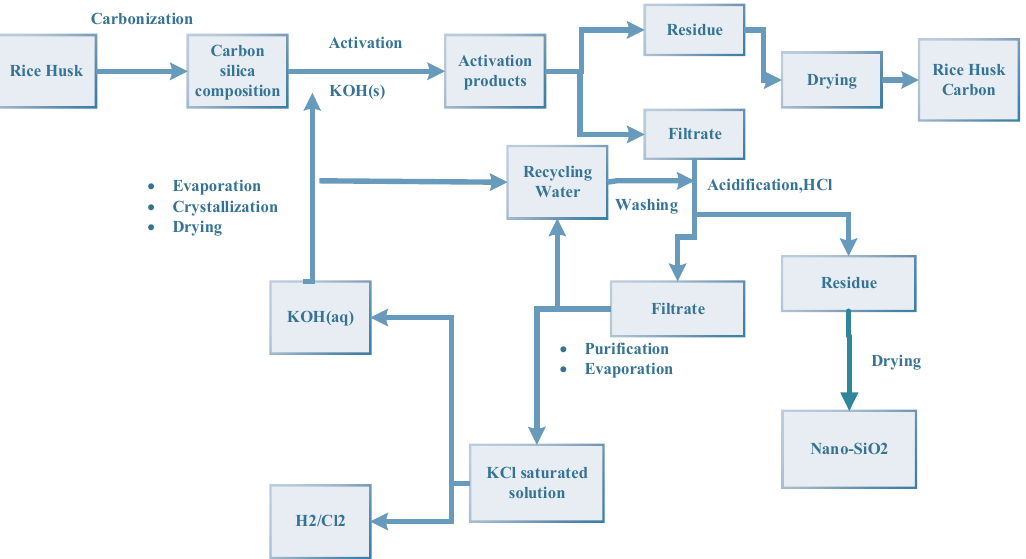
Figure 4. Schematic representation of cost-effective AC production technology. Reproduced with permission from [36]; Elsevier and Copyright Clearance Center, 2016.